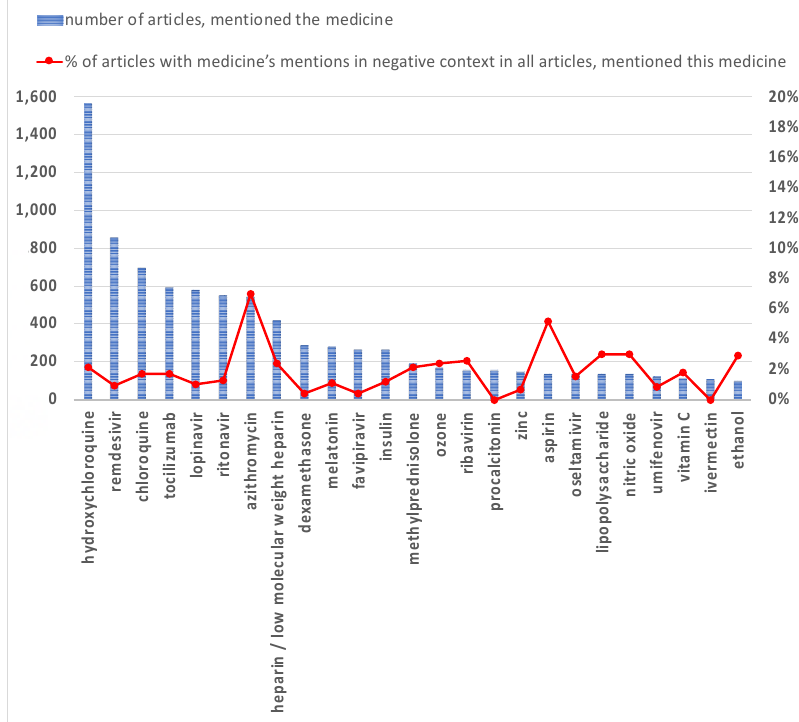
Figure 4. TOP-25 most mentioned medicines (UMLS Semantic Types: “pharmacological substances” and “biological substances”) in COVID-19 papers from 1 January 2019 till 1 February 2020. The blue histogram, left y -axis corresponds to the number of articles where medicine was mentioned. The red solid line, right y -axis corresponds to the percentage of articles with medicine’s mentions in a negative context with respect to all articles mentioning this medicine.